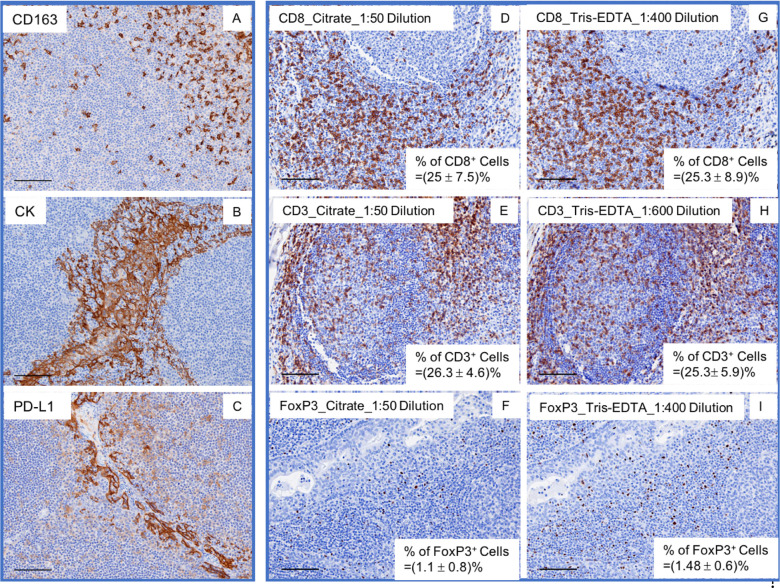
Antibody validation.Anti-CD163, CK, and PD-L1 were validated using the vendor’s provided antigen retrieval method Tis-EDTA (pH 9.0) as an antigen retrieval buffer (A, B, C). Anti-CD8, CD3, and FoxP3 were validated using the vendor’s suggested citrate buffer (pH 6.0) or Tris-EDTA (pH 9.0) in adjacent tissue sections (D-I). The frequency (mean+/-SD) of each biomarker was determined (D-I).